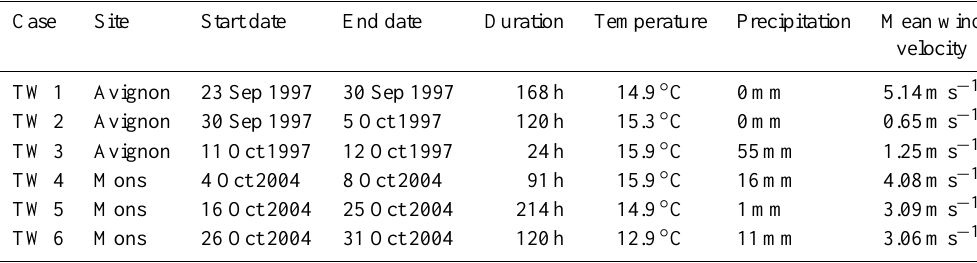
Table 3. Climatic forcing summary for the selected time windows (TWs).